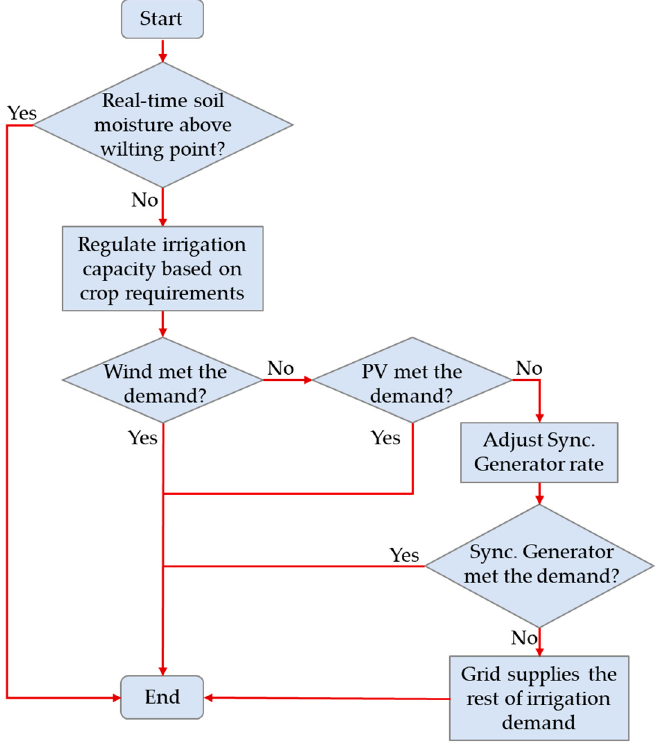
Figure 3. Flowchart of energy scheduling process in the developed agriculture irrigation model.